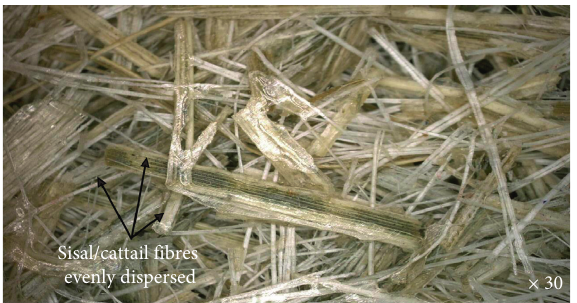
Figure 3: Micrograph of the sisal/cattail composite with 20% hybrid fibre weight fraction at constant fibre blend ratio.